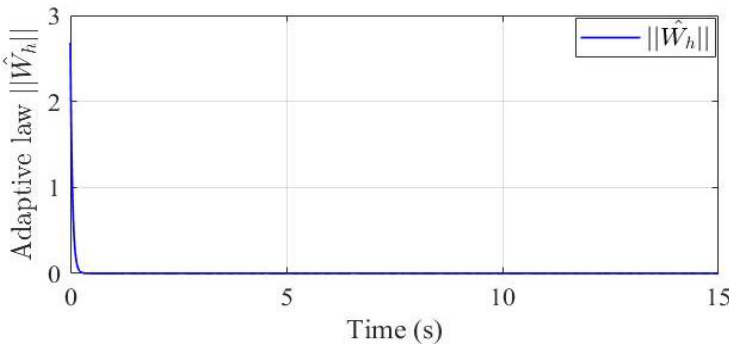
Figure 13. Adaptive law.